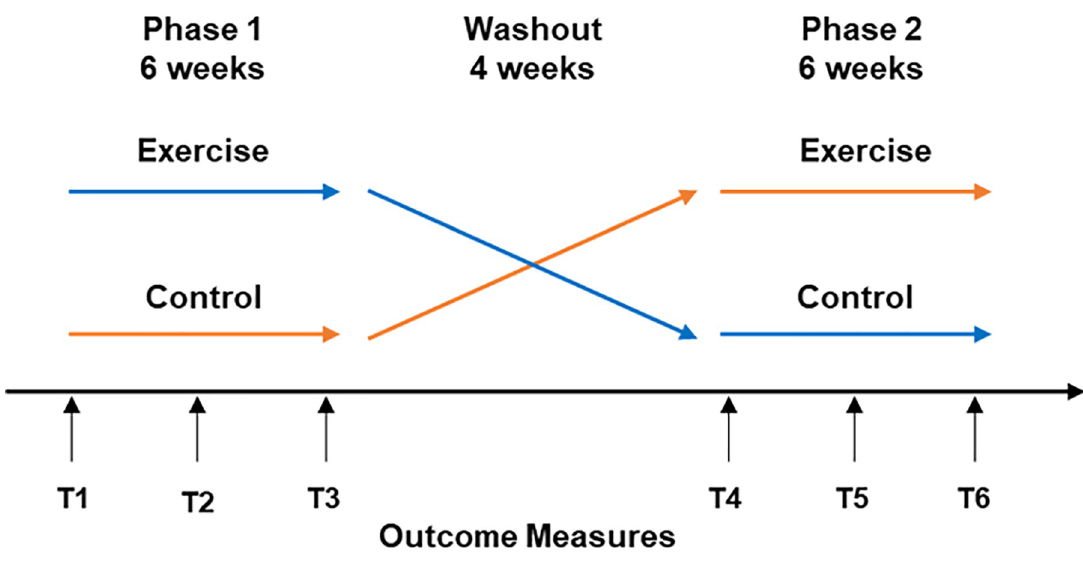
Fig 2. Experimental protocol of the study. T1: time point 1 (initial of phase 1); T2: time point 2 (mid way of phase 1); T3: time point 3 (final of phase 1); T4: time point 4 (initial of phase 2); T5: time point 5 (mid way of phase 2); T6: time point 6 (final of phase 2).